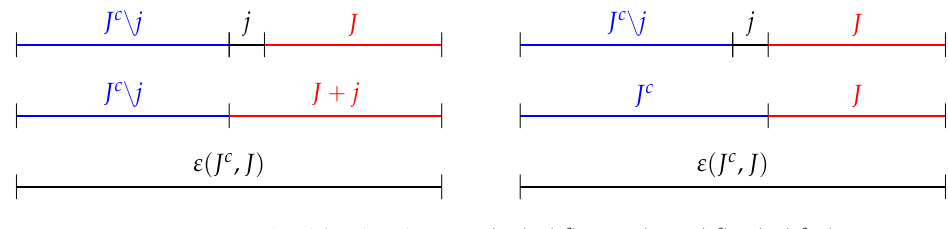
Figure 3. Visual aid for the identity σ p j , J q σ p J c z j , J ` j q “ σ p J c z j , j q σ p J c , J q